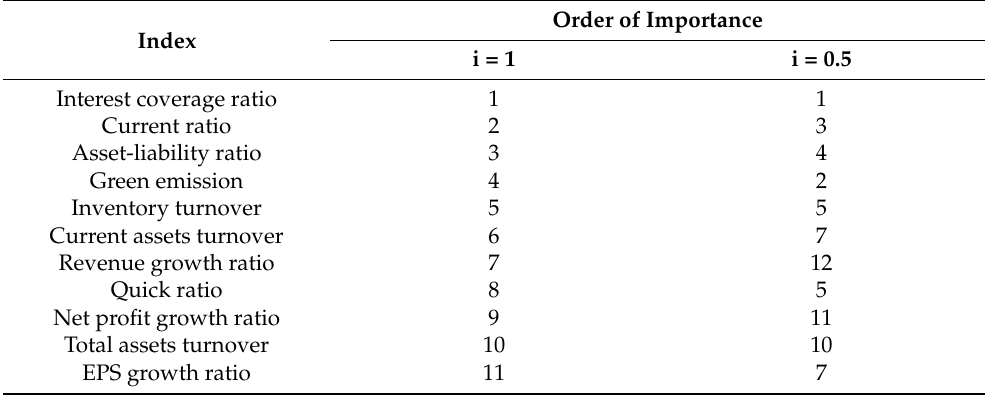
Table 6. Main influencing indicators of green credit risk under different